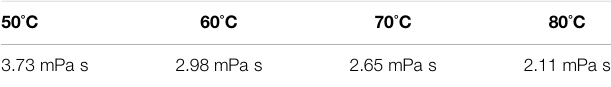
TABLE 2 | Viscosity of the MSA/CTAB mixed system under different temperatures.